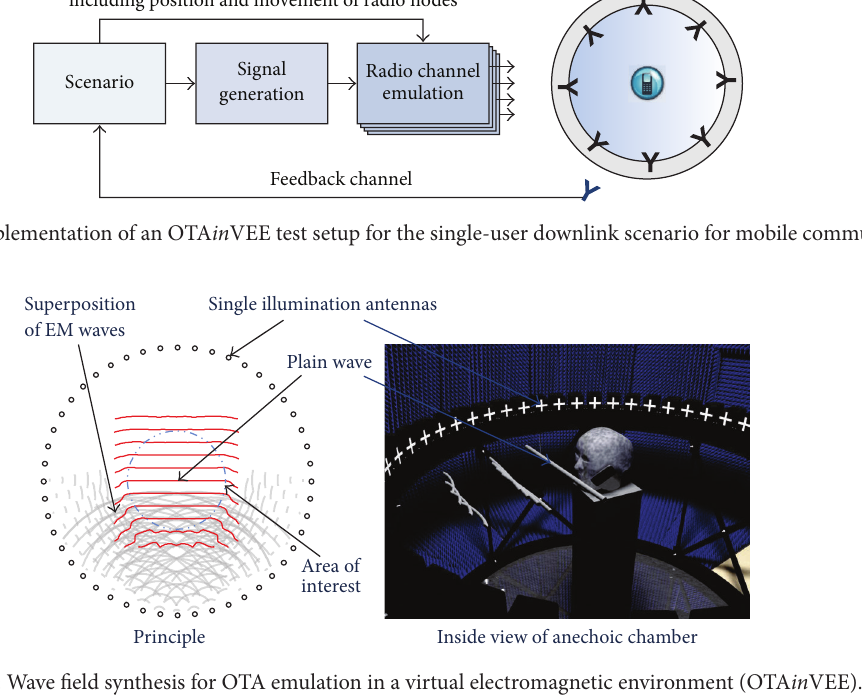
Figure 4: Wave field synthesis for OTA emulation in a virtual electromagnetic environment (OTA in VEE).